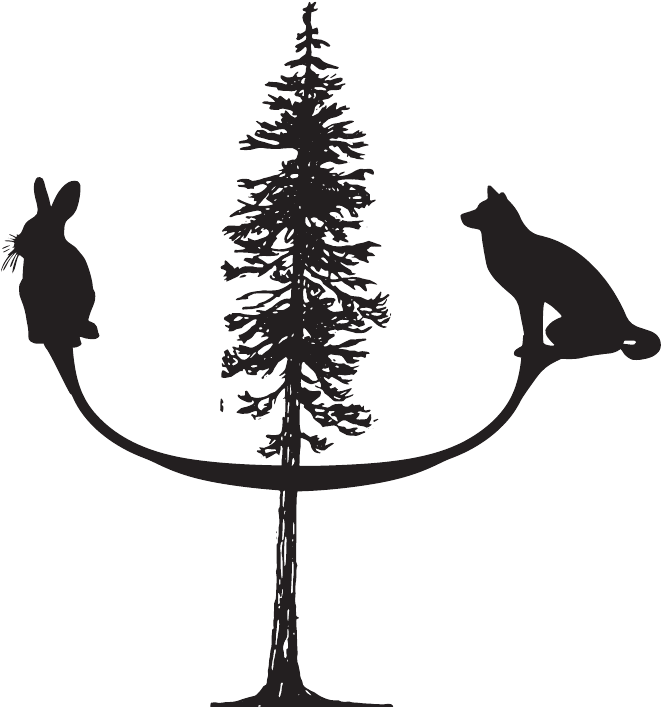
Fig 1. Artistic illustration. A predator and its prey balancing on the archetypal wavefunction C , a symbol of their entangled